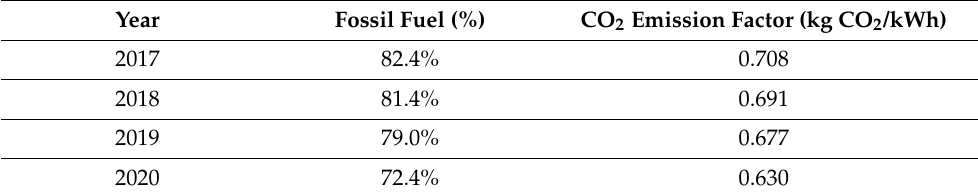
Table 1. Fossil fuel dependency (% fossil fuel) and CO 2 emission factor (kg CO 2 /kWh) for the Oahu electric power system from 2017 through 2020.